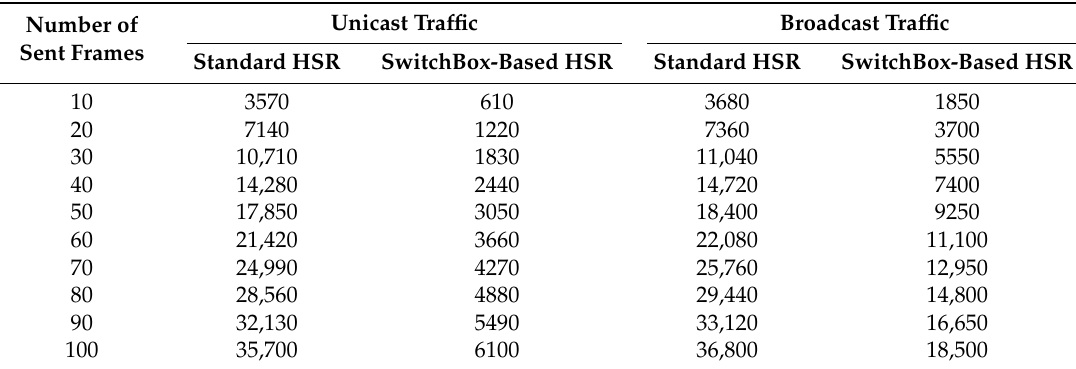
Table 4. Network traffic frames in case 1 of Simulation